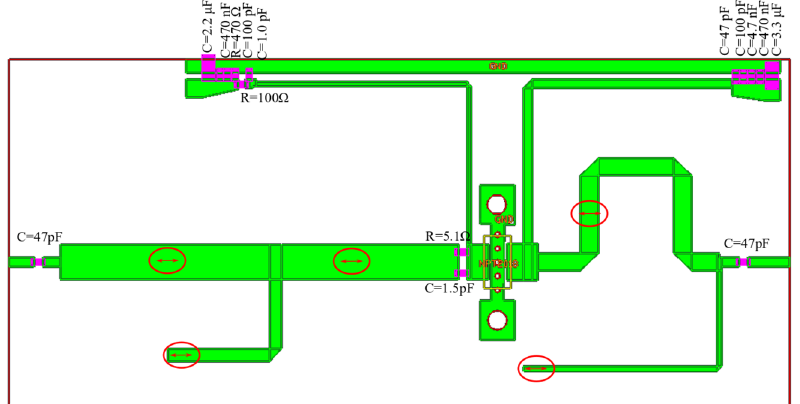
Figure 12. Assembly drawing of the PA with GaN HEMT NTP2018 optimized for minimum transmittance changes, modifications of the matching networks in relation to the previous version of the PA are marked in red.